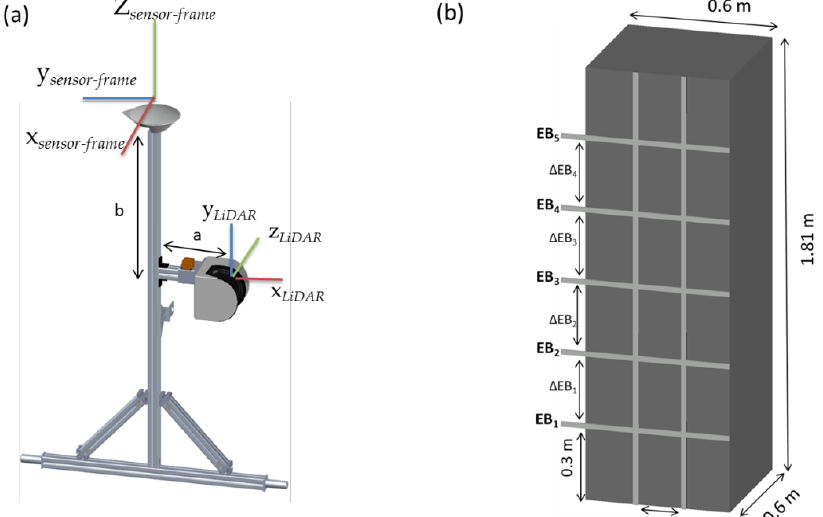
Figure 1. ( a ) Representation of the sensor-frame system showing the coordinate system of LiDAR and a real time kinematic global navigation satellite system (RTK-GNSS). ( b ) Metal box of known distances.